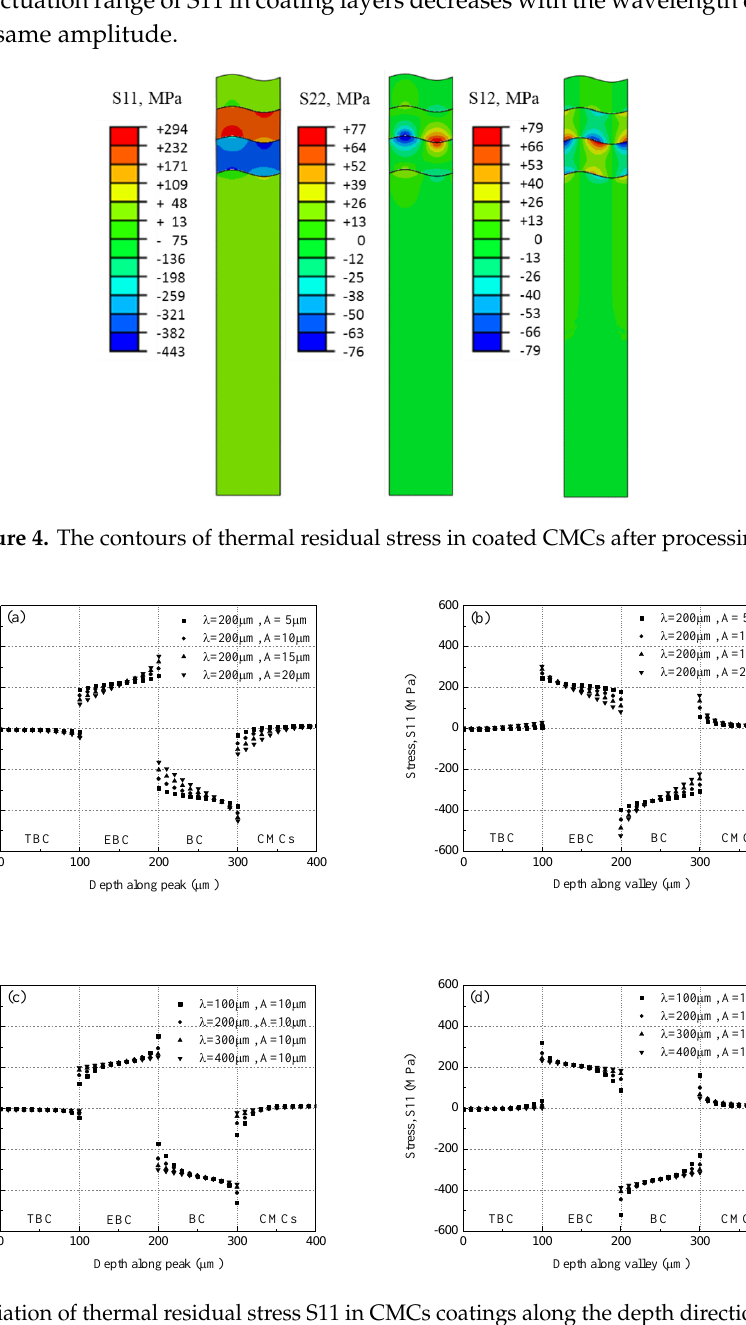
Figure 5. Variation of thermal residual stress S11 in CMCs coatings along the depth direction: the effect of amplitude at ( a ) peak path and ( b ) valley path; the effect of wavelength at ( c ) peak path and ( d ) valley path.